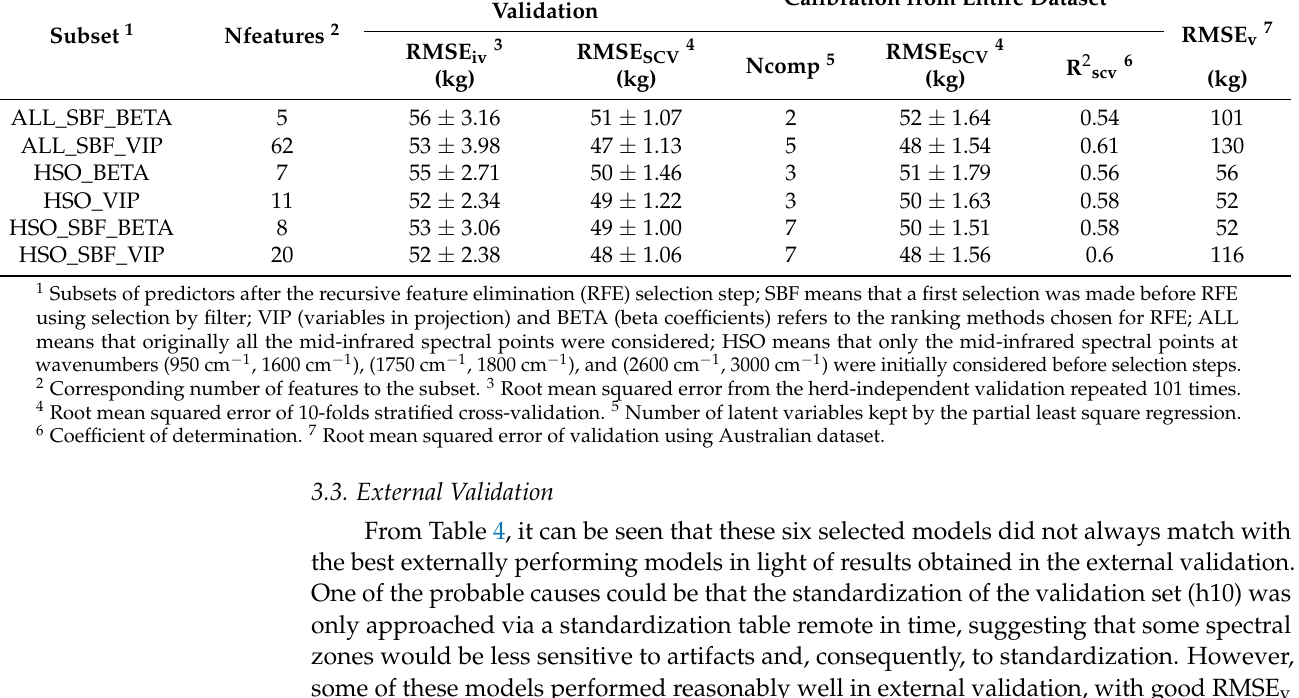
Table 4. Prediction performance of the six best models per kind of subsets.